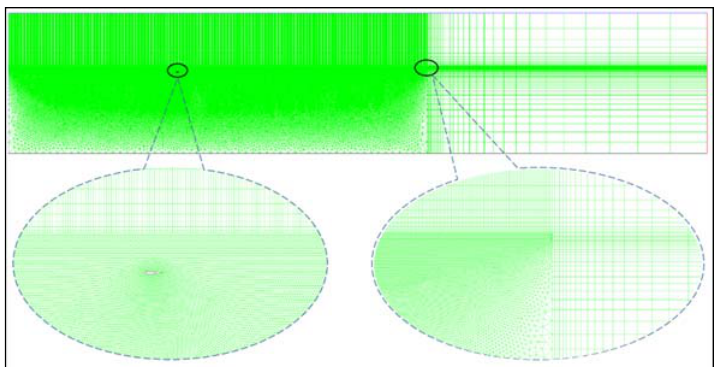
Figure 3. Schematic diagram of mesh systems.